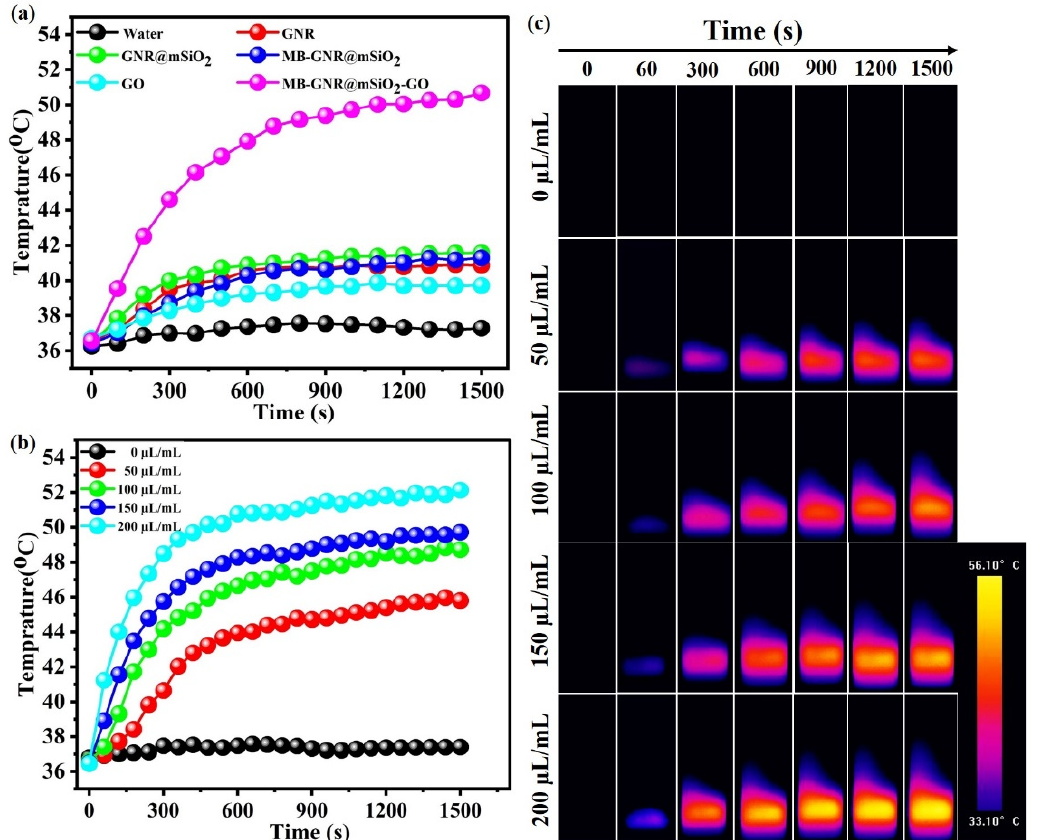
Figure 4. ( a ) The temperature variation curves of gold nanorods (GNRs), mesoporous